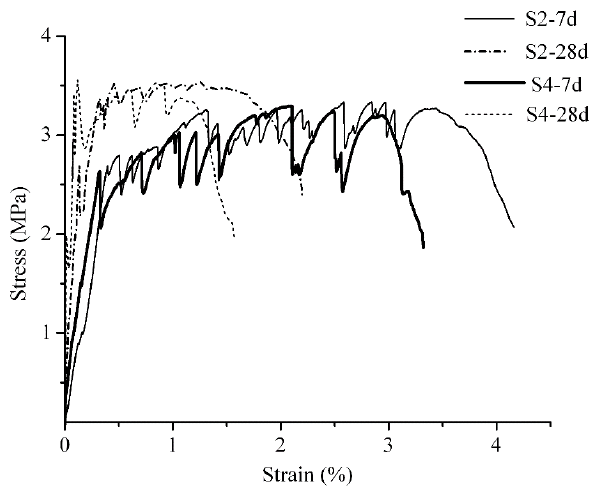
Figure 10. Stress-strain curve of S4 and S2.